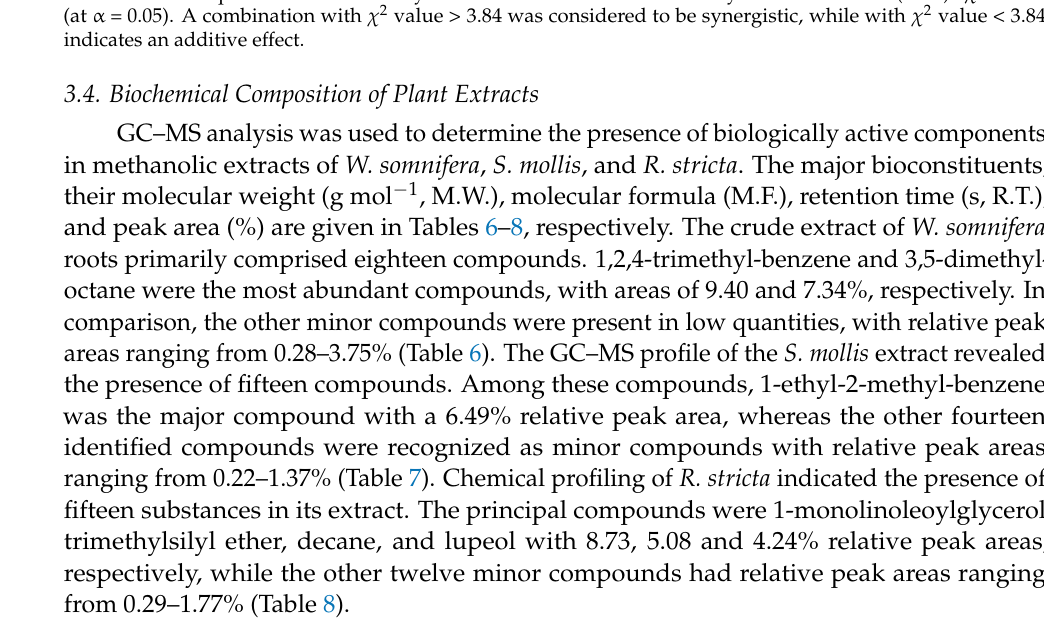
* Indicates the expected larval mortality derived from the formula of Trisyono and Whalon (1999). χ 2 = 3.84 (at α = 0.05). A combination with χ 2 value > 3.84 was considered to be synergistic, while with χ 2 value < 3.84 indicates an additive